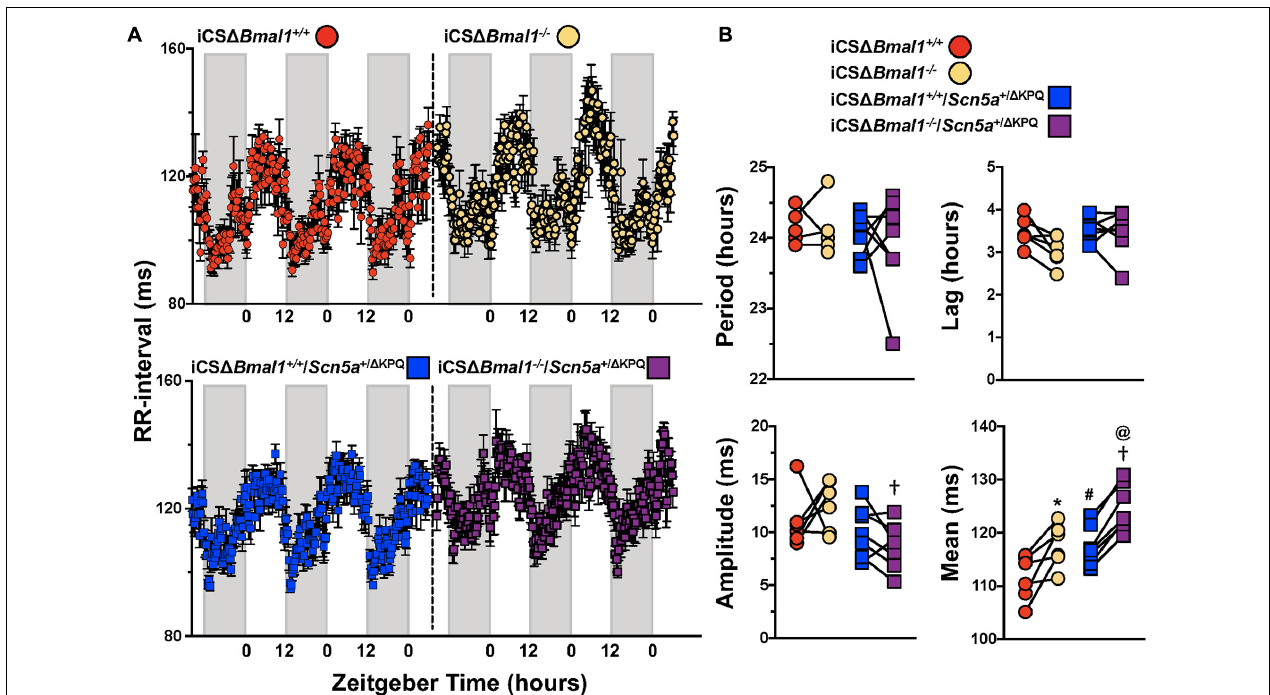
FIGURE 3 | Deletion of Bmal1 in adult cardiomyocytes increases the rhythm adjusted mean of the RR-interval. (A) RR intervals were averaged in 15-min bins over 3 days for iCS (cid:49) Bmal1 + / + (red circles) and iCS (cid:49) Bmal1 − / − (orange circles) (top graph, n = 6) or iCS (cid:49) Bmal1 + / + /Scn5a + /(cid:49) KPQ (blue circles) and iCS (cid:49) Bmal1 − / − /Scn5a + /(cid:49) KPQ (purple circles) mice (bottom graph, n = 7). Gray shaded regions on x-axis represent lights off. (B) The data for each mouse were fit to cosine curves to analyze period, lag, amplitude and median. The graphical representation of the change in period, amplitude and slope for iCS (cid:49) Bmal1 + / + (red circles) and iCS (cid:49) Bmal1 − / − (orange circles) and iCS (cid:49) Bmal1 + / + /Scn5a + /(cid:49) KPQ (blue squares) and iCS (cid:49) Bmal1 − / − /Scn5a + /(cid:49) KPQ (purple squares) mice are shown. Analysis showed that the rhythm adjusted mean between iCS (cid:49) Bmal1 + / + and iCS (cid:49) Bmal1 + / + /Scn5a + /(cid:49) KPQ ( # p < 0.05) were different; the amplitude and rhythm adjusted mean for iCS (cid:49) Bmal1 − / − or iCS (cid:49) Bmal1 − / − /Scn5a + /(cid:49) KPQ were different ( † p < 0.05); the rhythm adjusted mean for iCS (cid:49) Bmal1 + / + and iCS (cid:49) Bmal1 − / − were different (* p < 0.05); and the rhythm adjusted mean for iCS (cid:49) Bmal1 + / + /Scn5a + /(cid:49) KPQ and iCS (cid:49) Bmal1 − / − /Scn5a + /(cid:49) KPQ were different ( @ p <